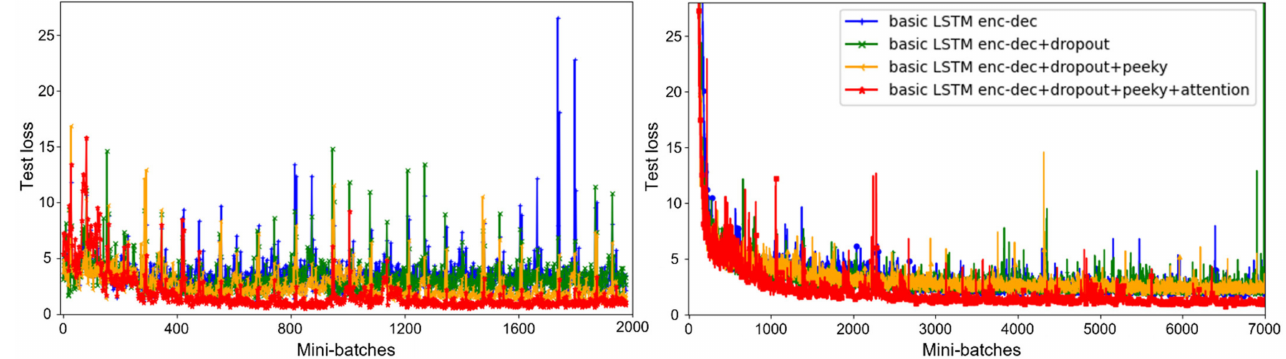
Figure 7. Learning curves: test and training loss.